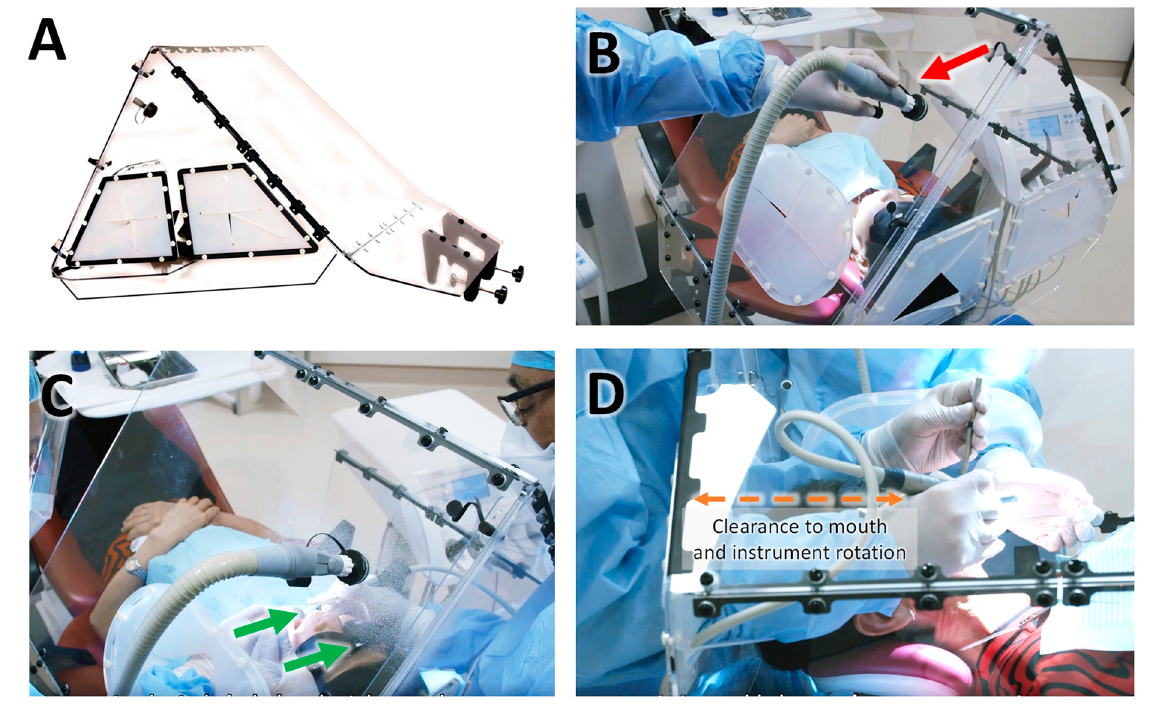
Figure 1. ( A ) D-DART design. ( B ) Dental suction canula attachment to the extraction valve (red arrow). ( C ) Dental aerosols are directed to the extraction valve (green arrows). ( D ) The distances from the back and lateral panels allow for ample movement of the instruments.